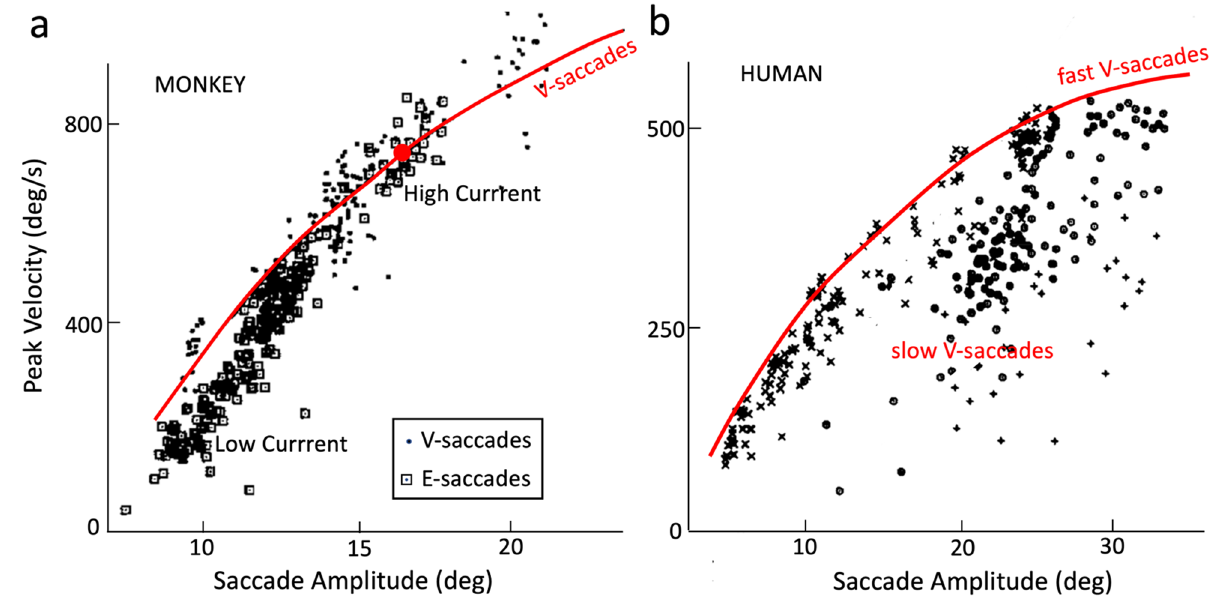
Figure 1. ( a ) Main-sequence relation of peak eye-velocity vs. saccade amplitude of monkey saccades for visually evoked (V-)saccades (dots) and for saccades elicited by electrical microstimulation at a single site in the superior colliculus at various current strengths (E-saccades; squares). The stimulation site in the motor map corresponded to a saccade amplitude of about 15 deg. For high stimulation currents, E-saccades and V-saccades had the same kinematics (large red dot). For the low stimulation currents at the site, two effects were observed: (i) evoked saccade amplitudes decreased, and (ii) evoked peak velocities decreased too, but fell systematically below the V-saccade main-sequence relation. Data adapted from 36 . ( b ) Human main-sequence relation for